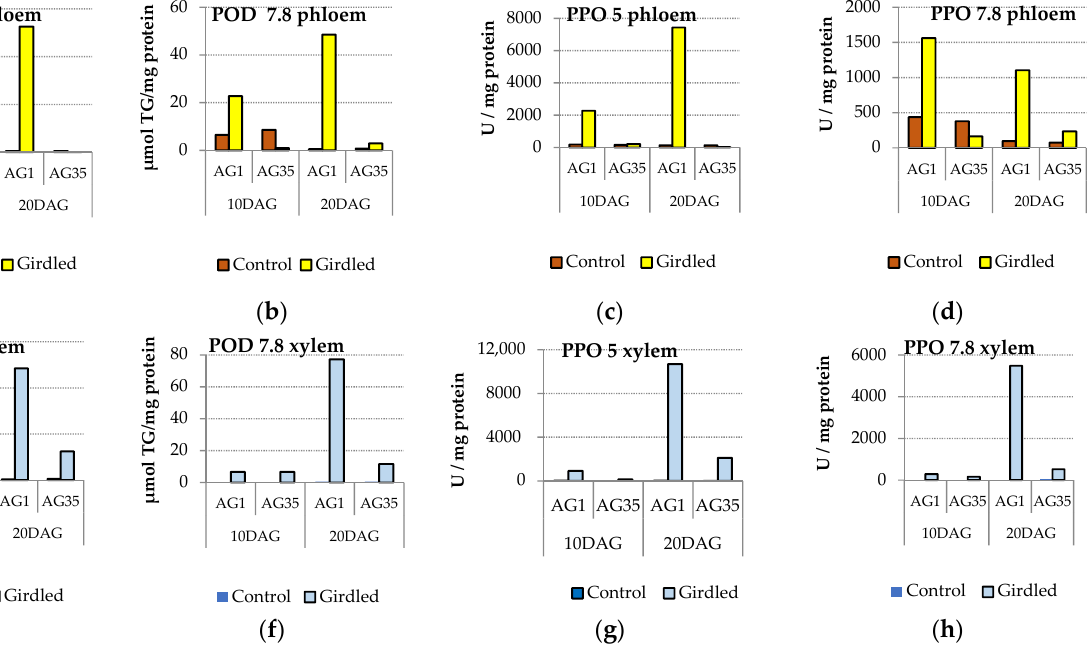
Figure 8. The activity of POD ( a , b , e , f ) and PPO ( c , d , g , h ) in the phloem ( a – d ) and xylem ( e – h ) of control and girdled trees.